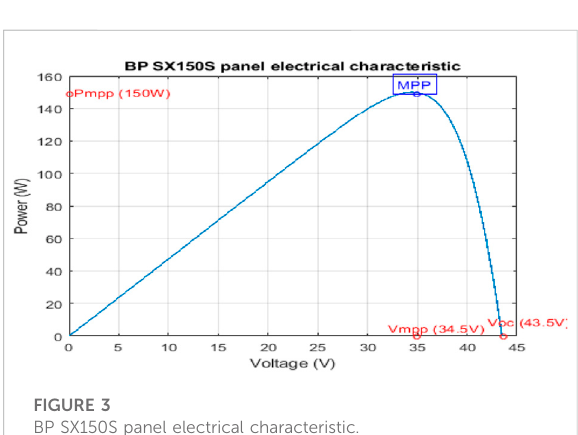
FIGURE 3 BP SX150S panel electrical